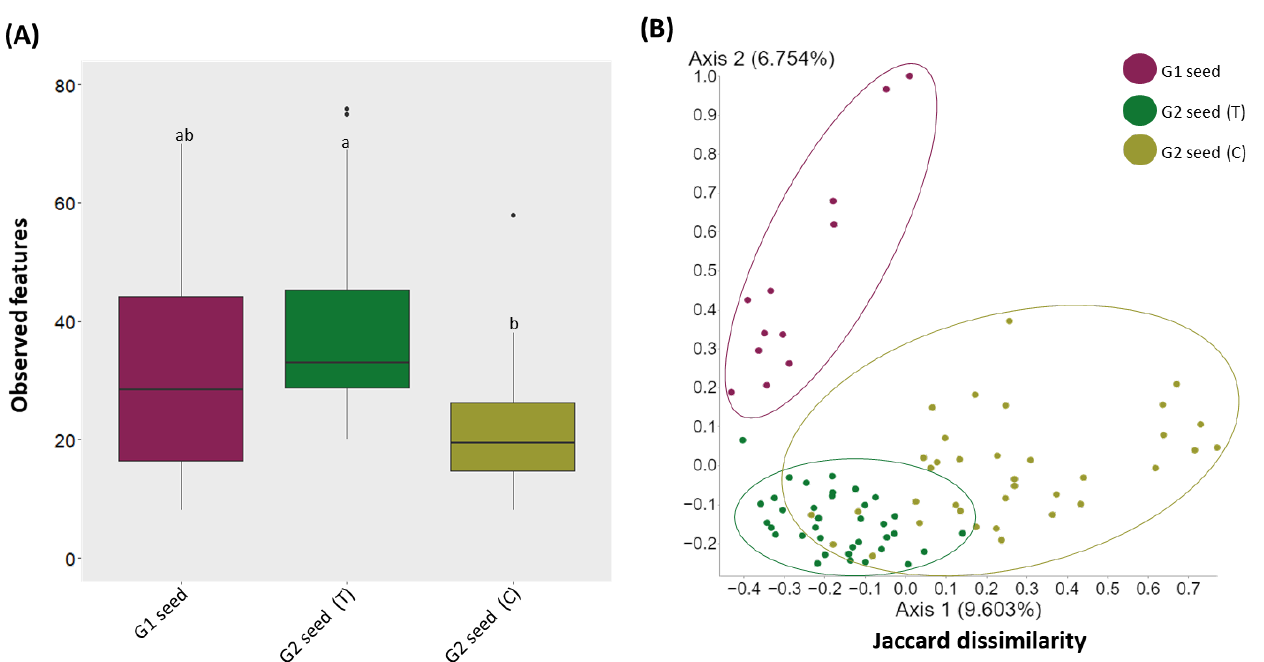
Figure 2. Alpha (observed features) and β -diversity (Jaccard dissimilarity) analyses of the seed microbiota of G. clandestina between G1 seed and G2 (T and C) seed. ( A ) “Box-and-Whiskers” plots visualize the observed features for G1 seed and G2 (T and C) seed. Significant differences ( p ≤ 0.05) were assessed by the Kruskal Wallis pairwise test and are indicated by the lower-case letters. ( B ) PCoA plots showing the distances between the bacterial community composition of G1 and G2 (T and C) seed. Significant differences in bacterial composition were tested using the ANOSIM pairwise test. Different colours of the bars ( A ) and points ( B ) represent the G1 and G2 (T and C) seed represent the plant organs for both soil treatments (T and C).